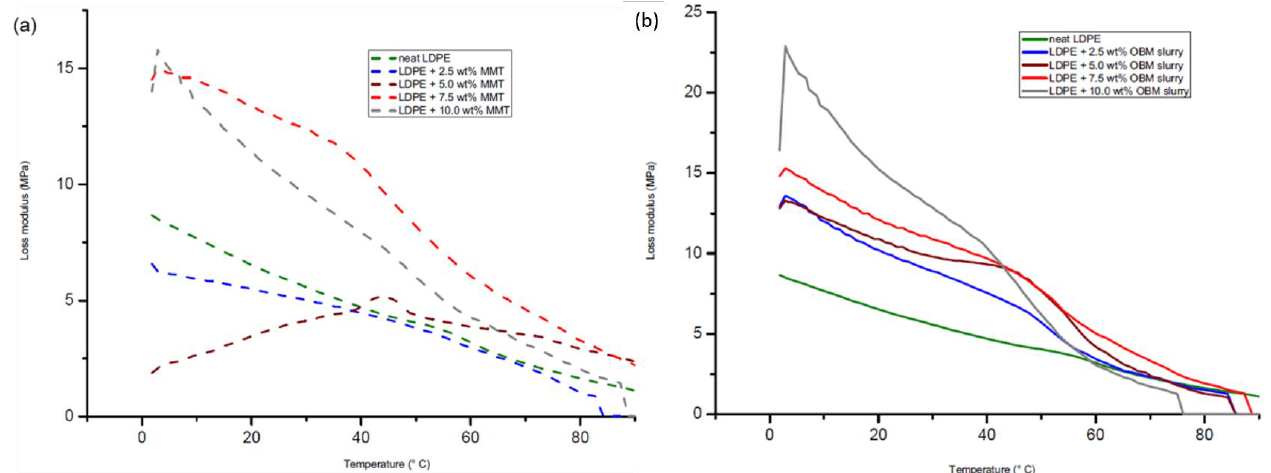
Figure 17. Influence of applied shear stress on the loss modulus of ( a ) neat LDPE and LDPE/MMT and ( b ) neat LDPE and LDPE/OBM slurry nanocomposites.